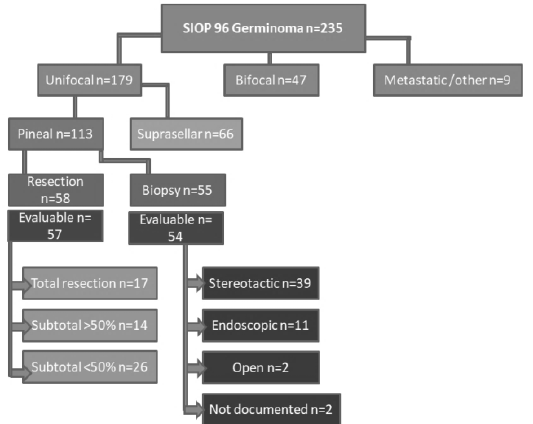
Figure 1. SIOP GCT CNS 96 study patients and classification of two groups (resection and biopsy). Concerning the contribution of the countries in respect of pineal germinoma, patients were registered from 14 countries. Most patients were registered from Germany n = 32, followed by France n = 20, the United Kingdom n = 17, Austria n = 8, Switzerland n = 7, the Netherlands n = 6, Poland n = 6, Belgium n = 4, Denmark n = 3, Greece n = 3, Italy n = 3, Norway n = 2, Spain n = 1, and Sweden n = 1 (total of 113 pineal germinoma). In this study, we enrolled all 113 patients with an isolated pineal gland germinoma and divided them into 2 groups: Group 1 (resection group) included 58 patients who underwent a primary resection, and Group 2 (biopsy group) included 55 patients who were initially